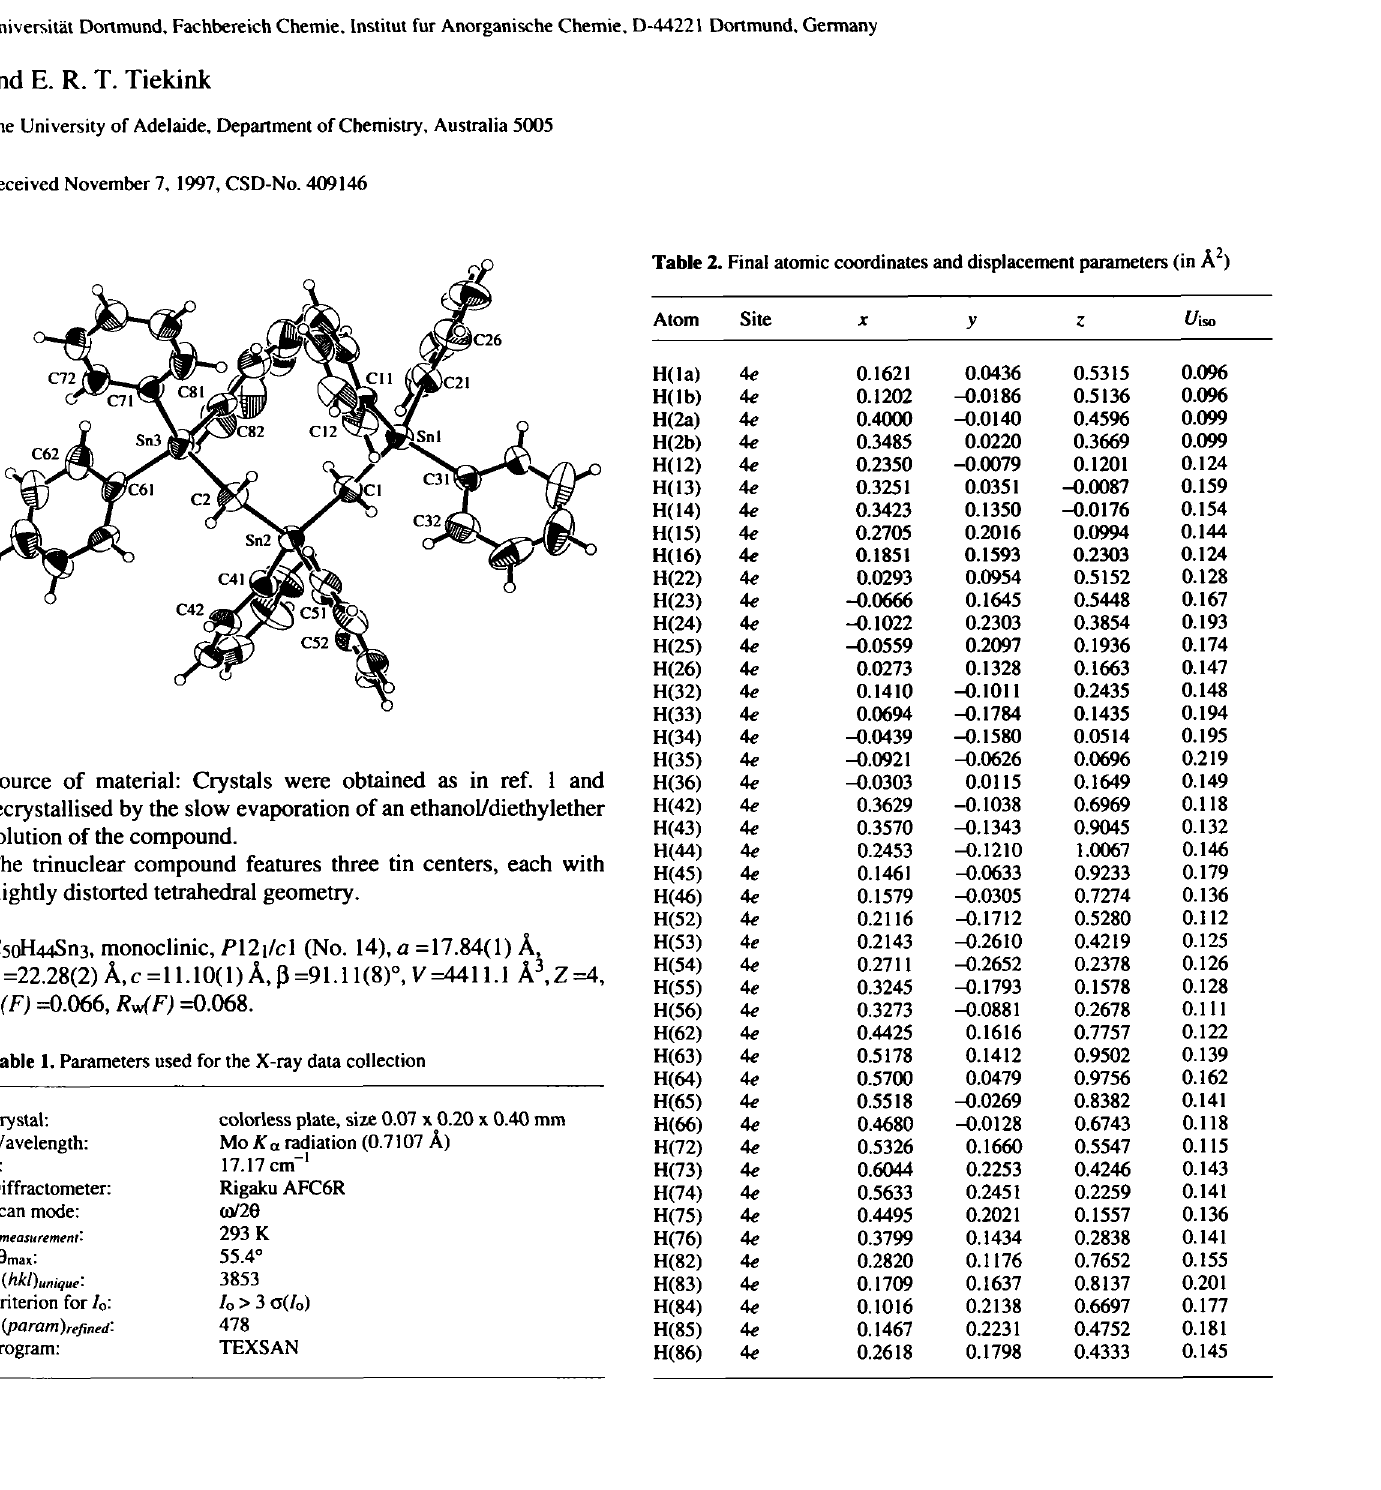
Table 2. Final atomic coordinates and displacement parameters (in A^)